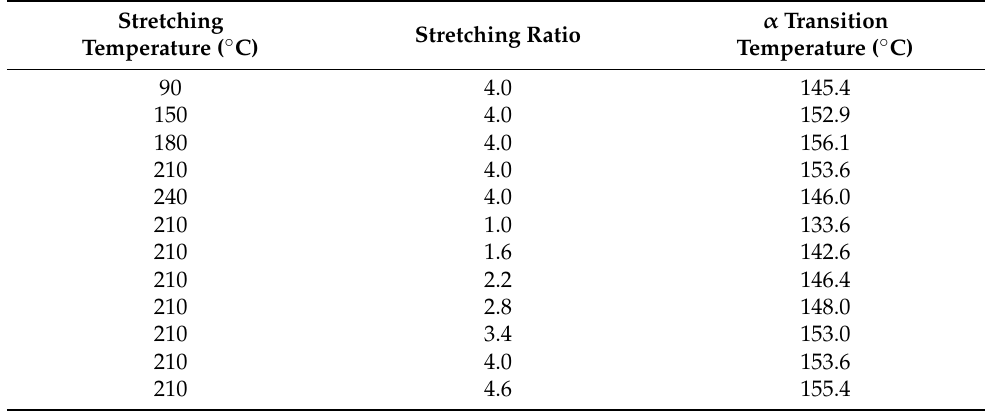
Table 2. The α transition temperature of PA12T samples prepared at different stretching ratios and stretching